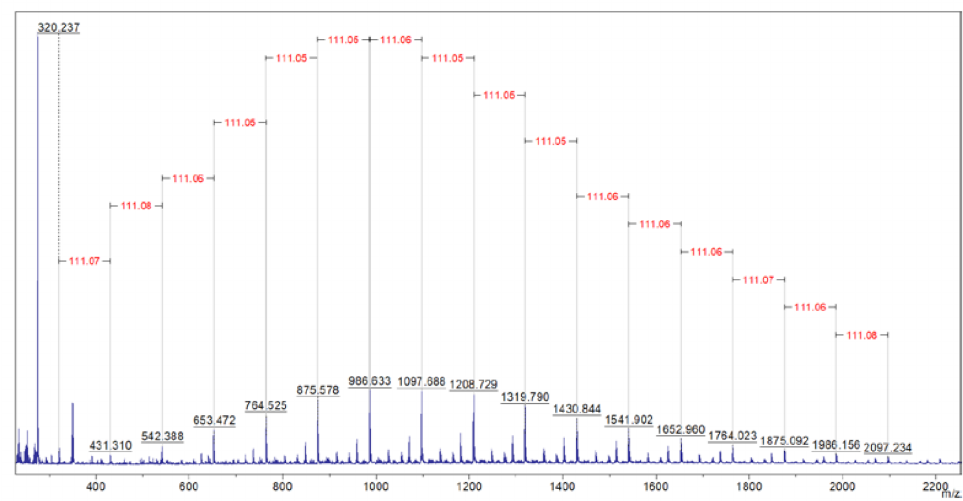
Figure 3. MALDI-TOF is the spectrum of a copolymer synthesized at a molar ratio of VP/GMA equal to 1.4, registered under conditions of laser desorption with a DHB